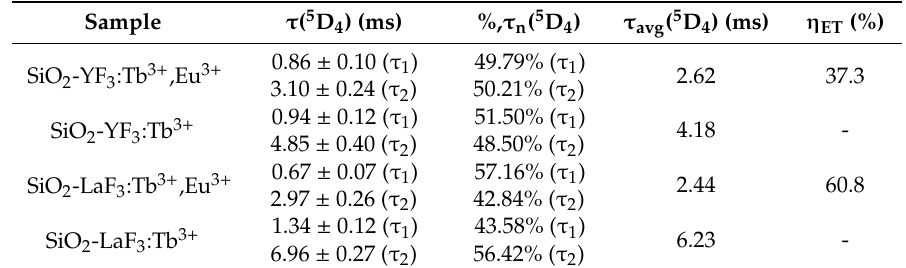
Table 2. Luminescence lifetimes of the 5 D 4 state of Tb 3 + , their contribution and energy transfer (ET) e ffi ciencies ( η ET ) for fabricated